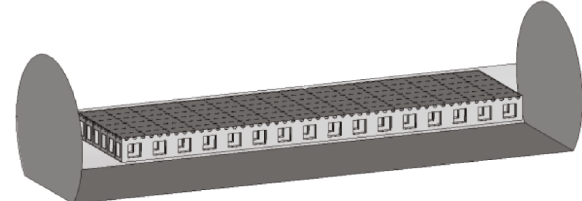
Figure 3: Frame-type tool and the simplified autoclave model. Table 1: Thermal conductivity of the INVAR alloy. Density ρ (kg · m − 3